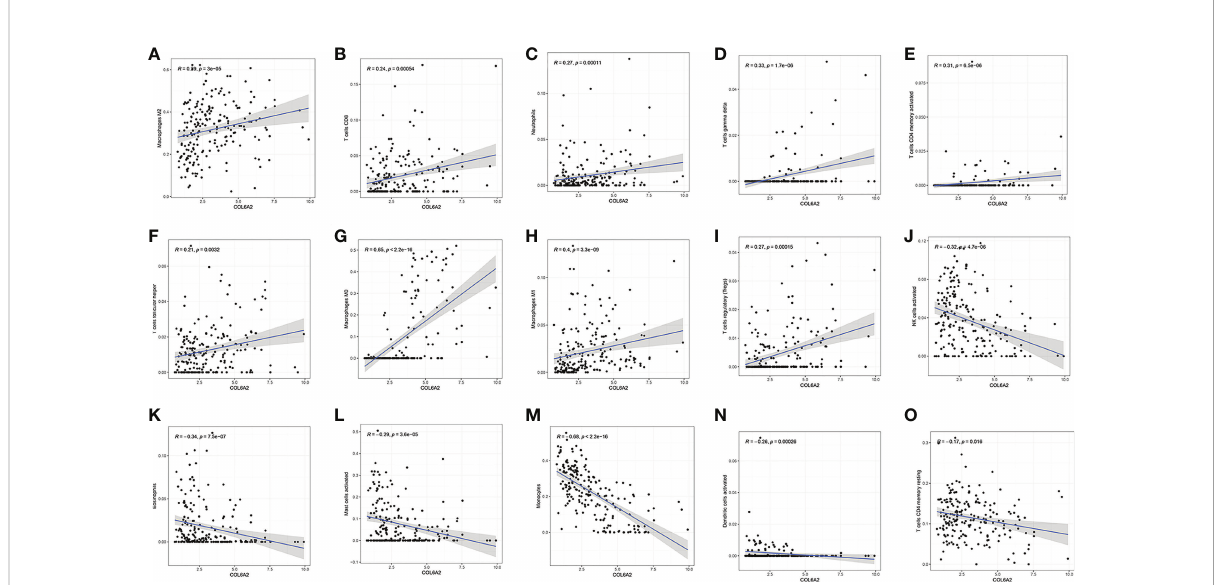
FIGURE 9 Correlation between COL6A2 expression and immune cells, (A – I) COL6A2 expression is positively correlated with immune cells such as Macrophages M2, T cells CD8, Neutrophils, T cells gamma delta, T cells CD4 memory activated, T cells follicular helper, Macrophages M0, Macrophages M1, and T cells regulatory (Tregs), (J – O) COL6A2 expression is negatively correlated with NK cells activated, Eosinophils, Mast cells activated, Monocytes, Dendritic cells activated, T cells CD4 memory